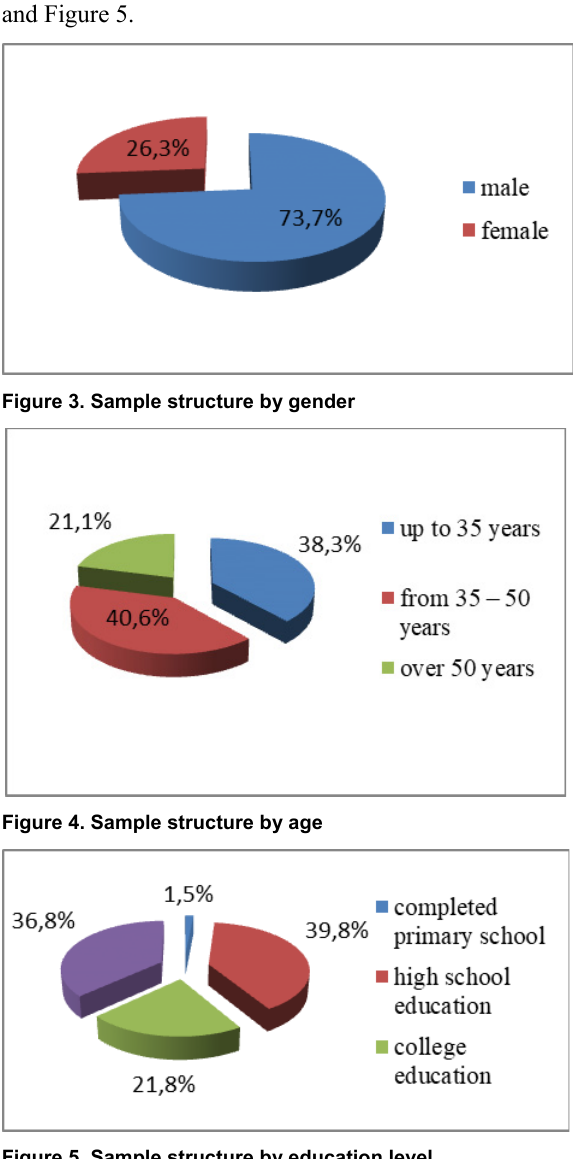
Figure 5. Sample structure by education level Regression analysis (linear regression model)